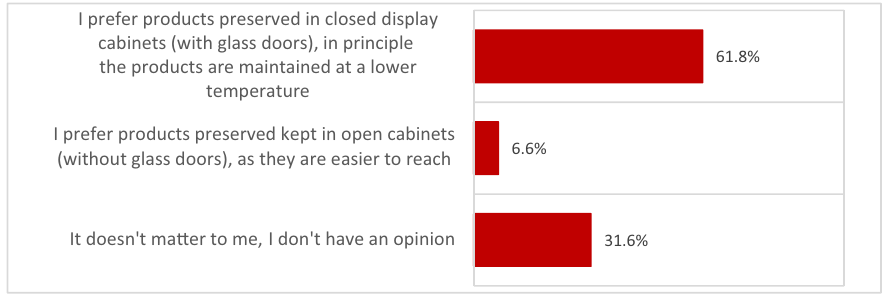
Figure 9: Results for the question: “ Indicate your general opinion or preference regarding the products displayed in refrigeration or freezing cabinets ”